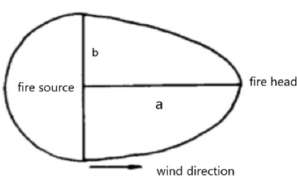
Figure 2. Mathematical model of forest fire spread [12]; the arrow indicates the wind direction, line a indicates the distance of fire head spread, which is the longest, and line b indicates the distance of fire spread in the crosswind direction.